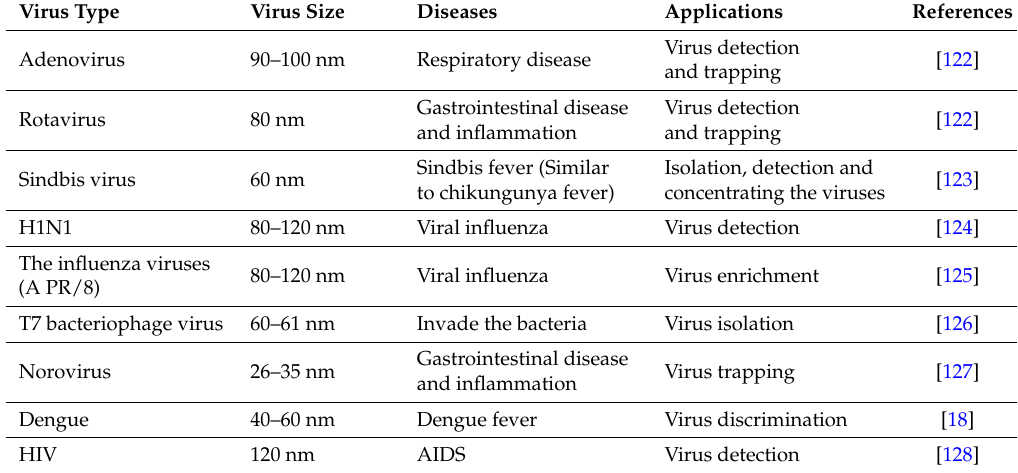
Table 6. DEP investigations on